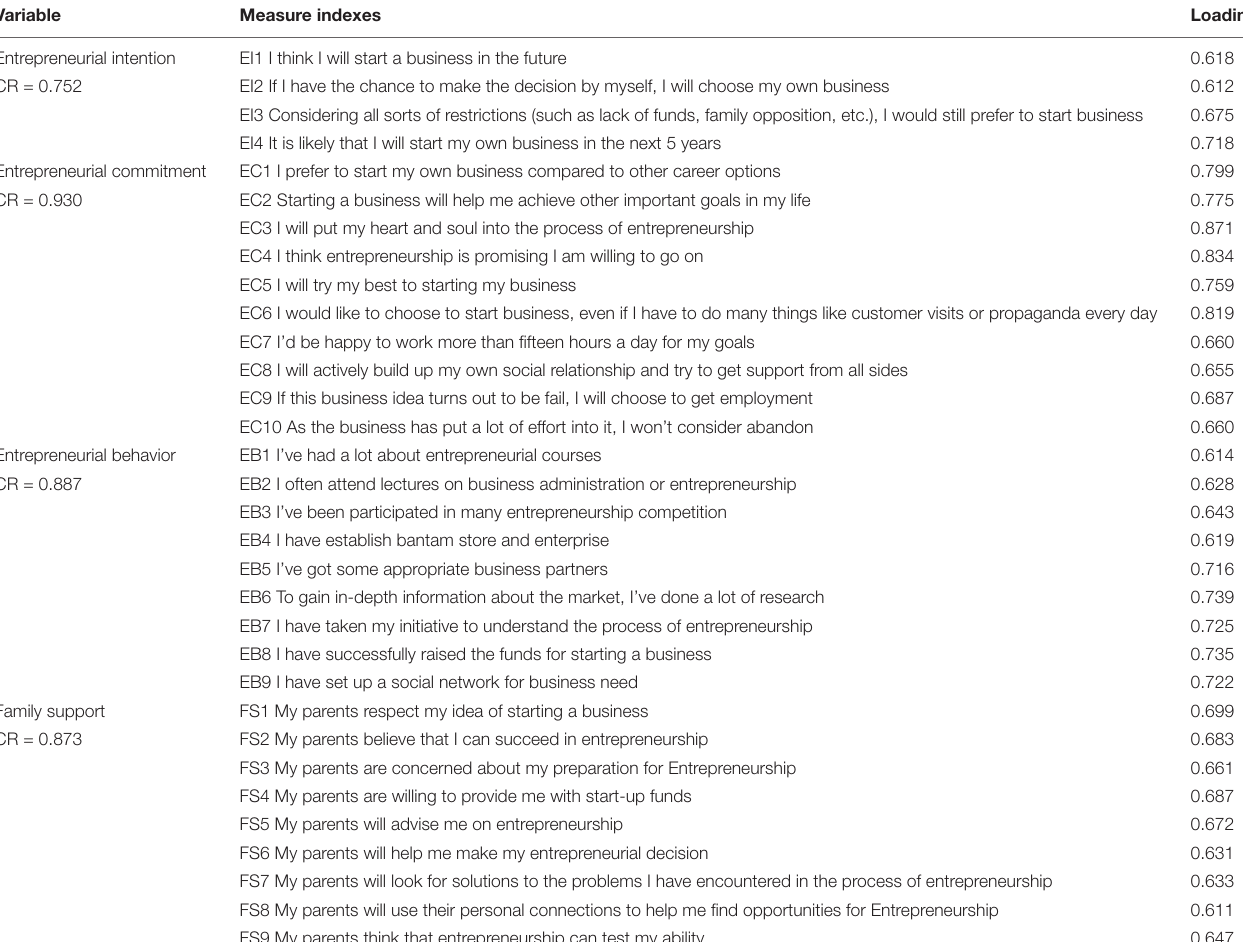
TABLE 2 | Reliability and validity.